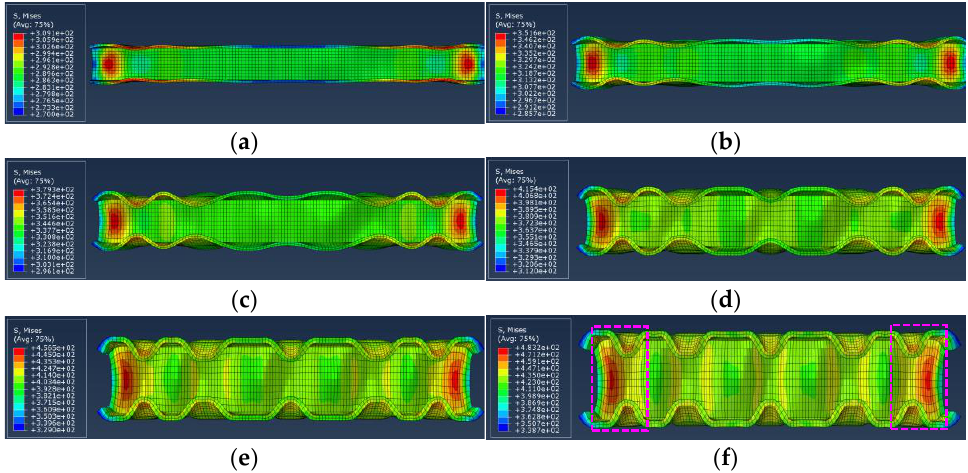
Figure 11. Buckling development of H-section steel core in compression for the second time. ( a ) ε = 0. ( b ) ε = − 0.67%. ( c ) ε = −1.28% . ( d ) ε = −2.08% . ( e ) ε = − 2.97%. ( f ) ε = −3.50% . ( b ) ε = − 0.67%. ( c ) ε = − 1.28%. ( d ) ε = − 2.08%. ( e ) ε = − 2.97%. ( f ) ε = −